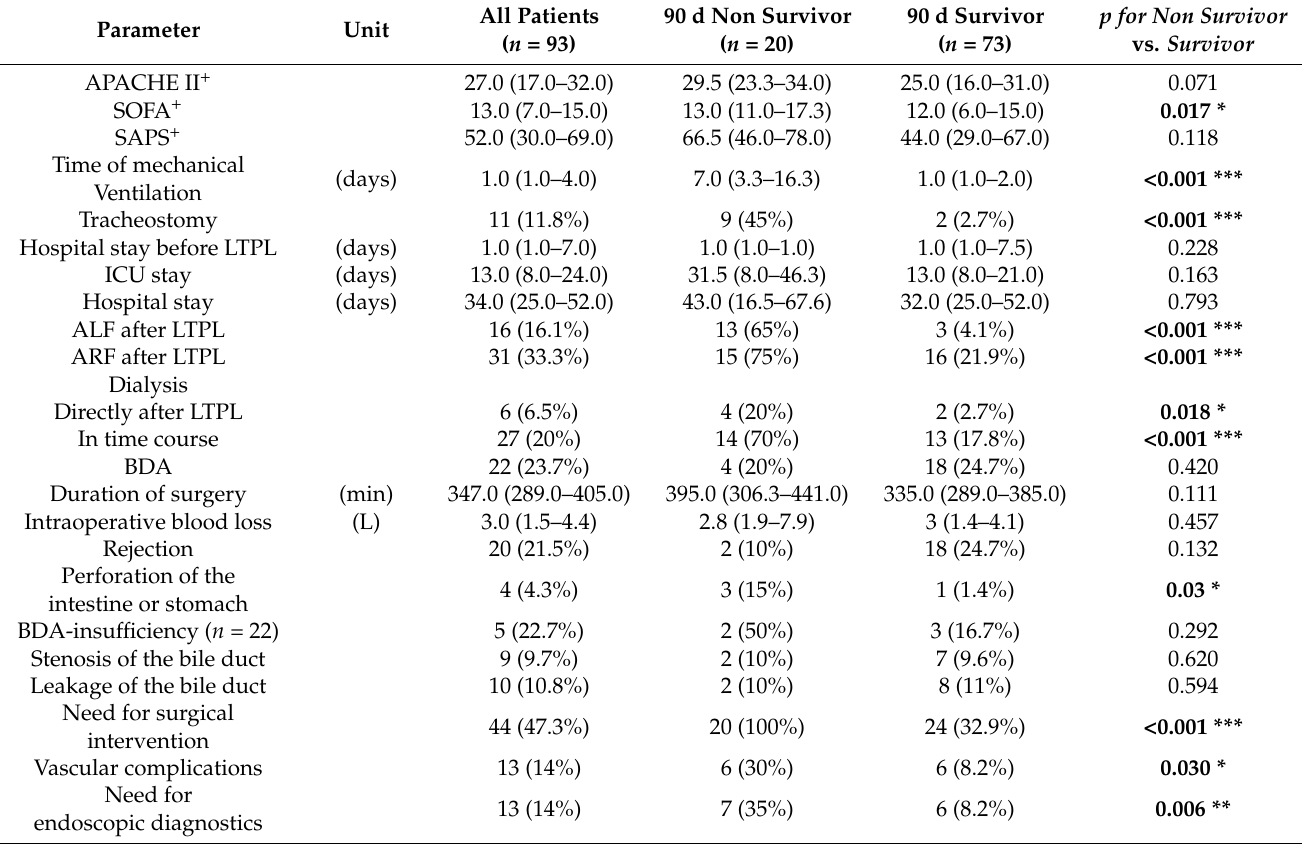
Table 2. Information regarding hospital stay and extensive care